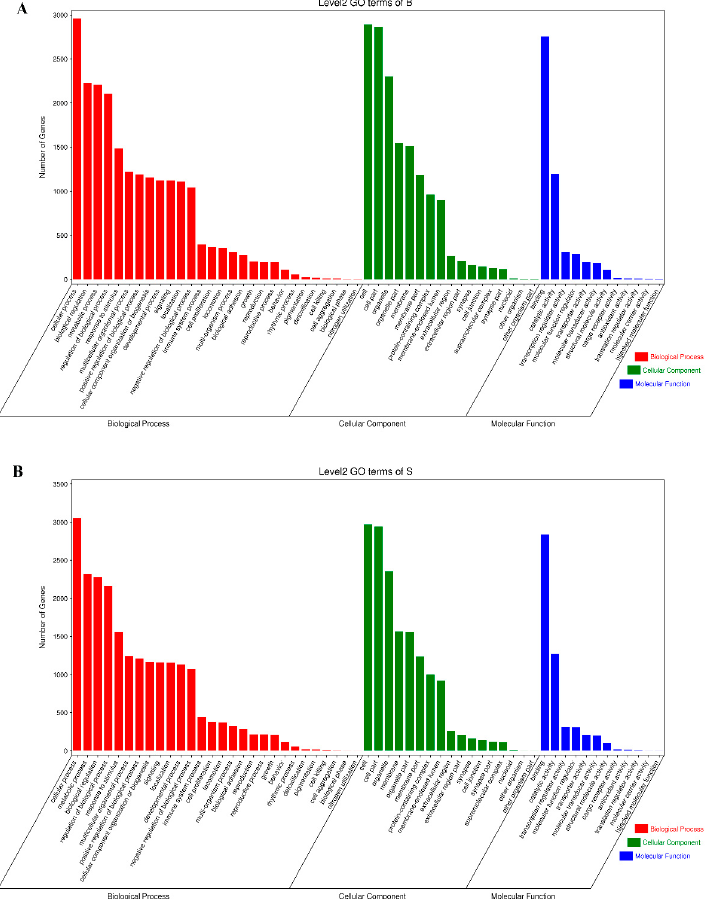
Figure 4. Go enrichment analysis of differential peak related genes; (A) Go enrichment classification histogram of muscle tissue; (B) Go enrichment classification histogram of fat tissue.